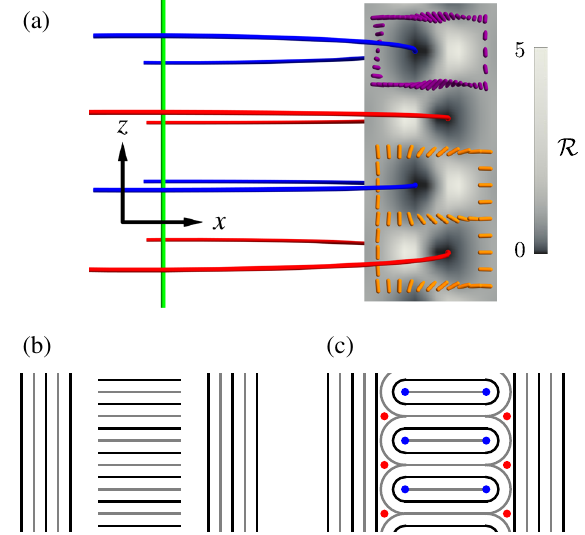
FIG. 1. The cholesteric interpolation of Eq. (4). (a) A χ 2 line (green) at r ¼ 0 surrounded by λ (blue) and λ − 1 (red) rings near r ¼ r R in a portion of the xz 0 . The grey scale is a density plot of plane; zeros (black) indicate defects in P . Orange rods show P and its nontrivial winding around the defect rings; purple rods show n , which is nonsingular. (b) Level sets of the cholesteric ϕ field, in the small and large r limits. (c) Filling space between the two boundaries requires dislocations in the layers, realized as (cid:3) π disclination pairs. ϕ ∈ Z are in black; half-layers are in